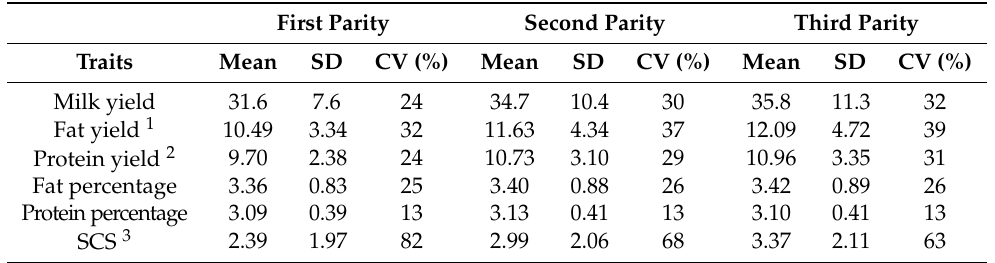
Table 1. Descriptive statistics for milk yield and compositions for the first three parities in Holstein dairy cows in